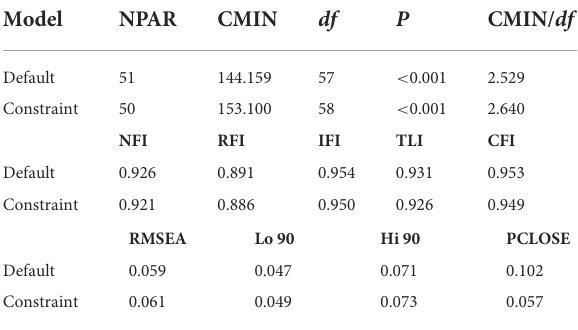
TABLE 4 Grouping regression of the constraint model vs. the default